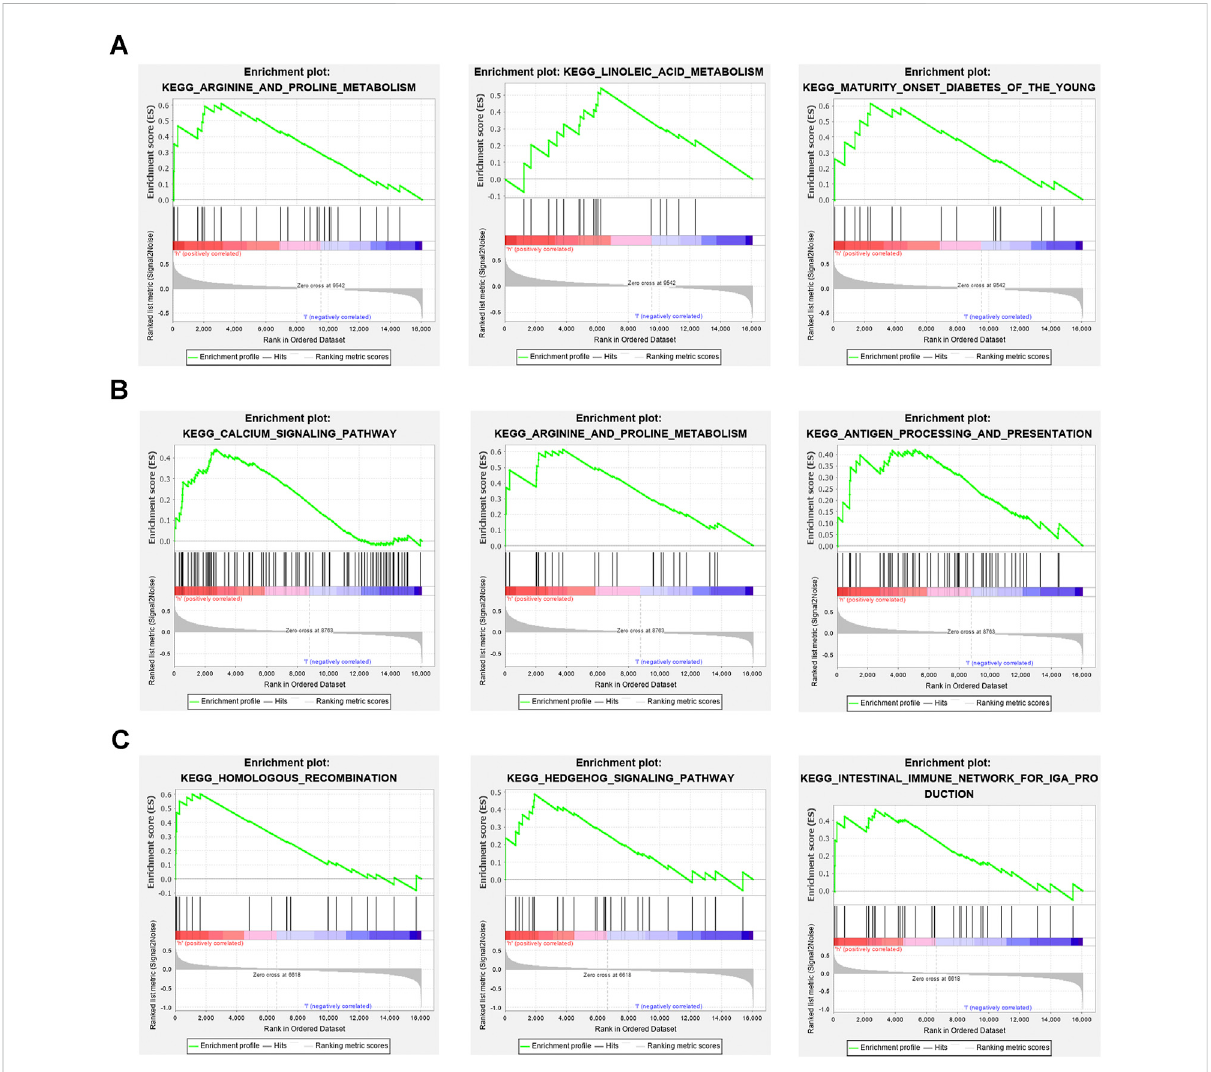
FIGURE 8 GSEA enrichment analysis of three core genes (A) The main enriched pathways with high expression for OAS1 are ARGININE AND PROLINE METABOLISM,LINOLEICACIDMETABOLISM,andMATURITYONSETDIABETESOFTHEYOUNG. (B) Themainenrichedpathwaysofhighexpression for SECTM1 are CALCIUM SIGNALING PATHWAY, ARGININE AND PROLINE METABOLISM, and ANTIGEN PROCESSING AND PRESENTATION. (C) The main enriched pathways with high expression in SNW1 are HOMOLOGOUS RECOMBINATION, HEDGEHOG SIGNALING PATHWAY, and INTESTINAL IMMUNE NETWORK FOR IGA